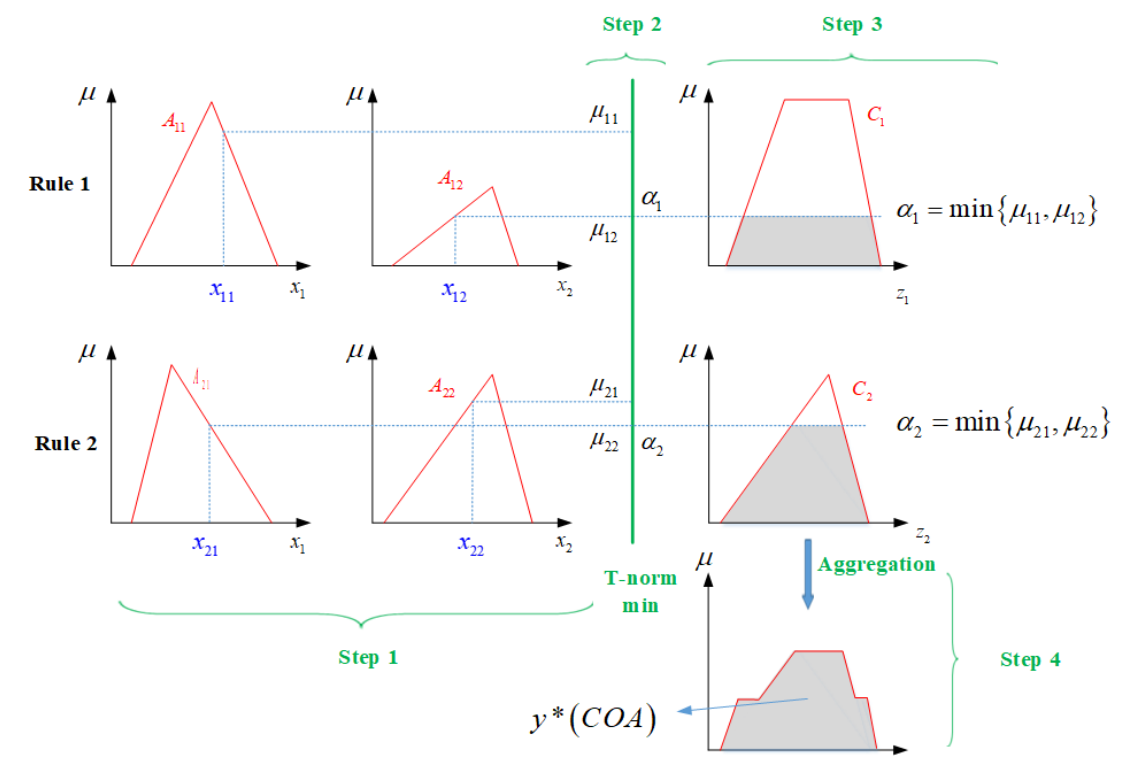
Figure 4. Structure of the Mamdani fuzzy inference system (adapted from [34]).